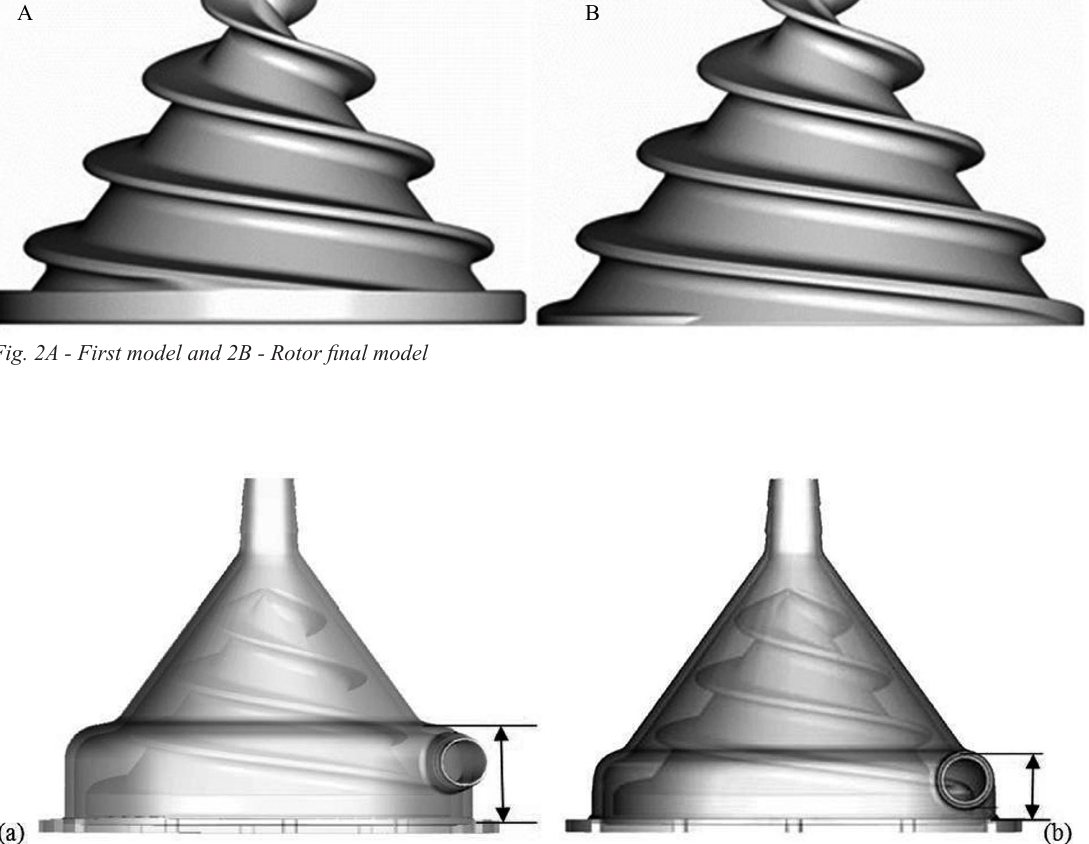
Fig. 3A - Housing initial model and 3B - Housing final model with change in output port